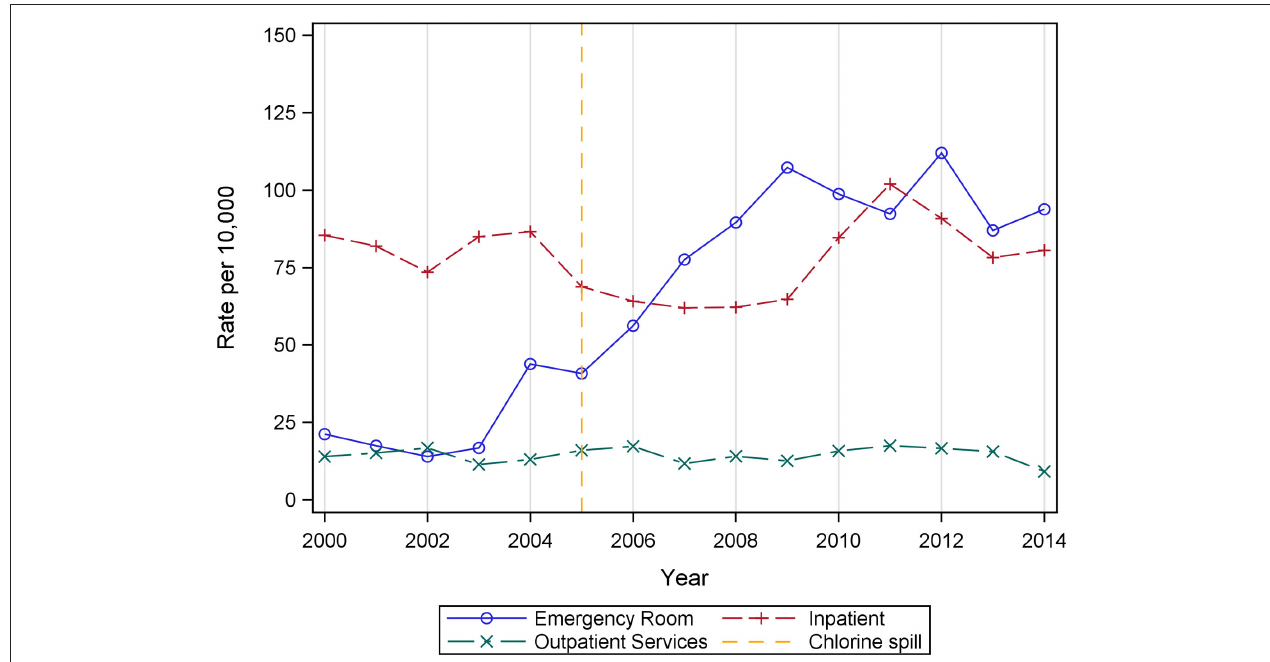
FIGURE 2 | Annual rates of hospital discharges with a primary or secondary diagnosis of hypertension by visit type among Graniteville-area residents, 2000–2014.